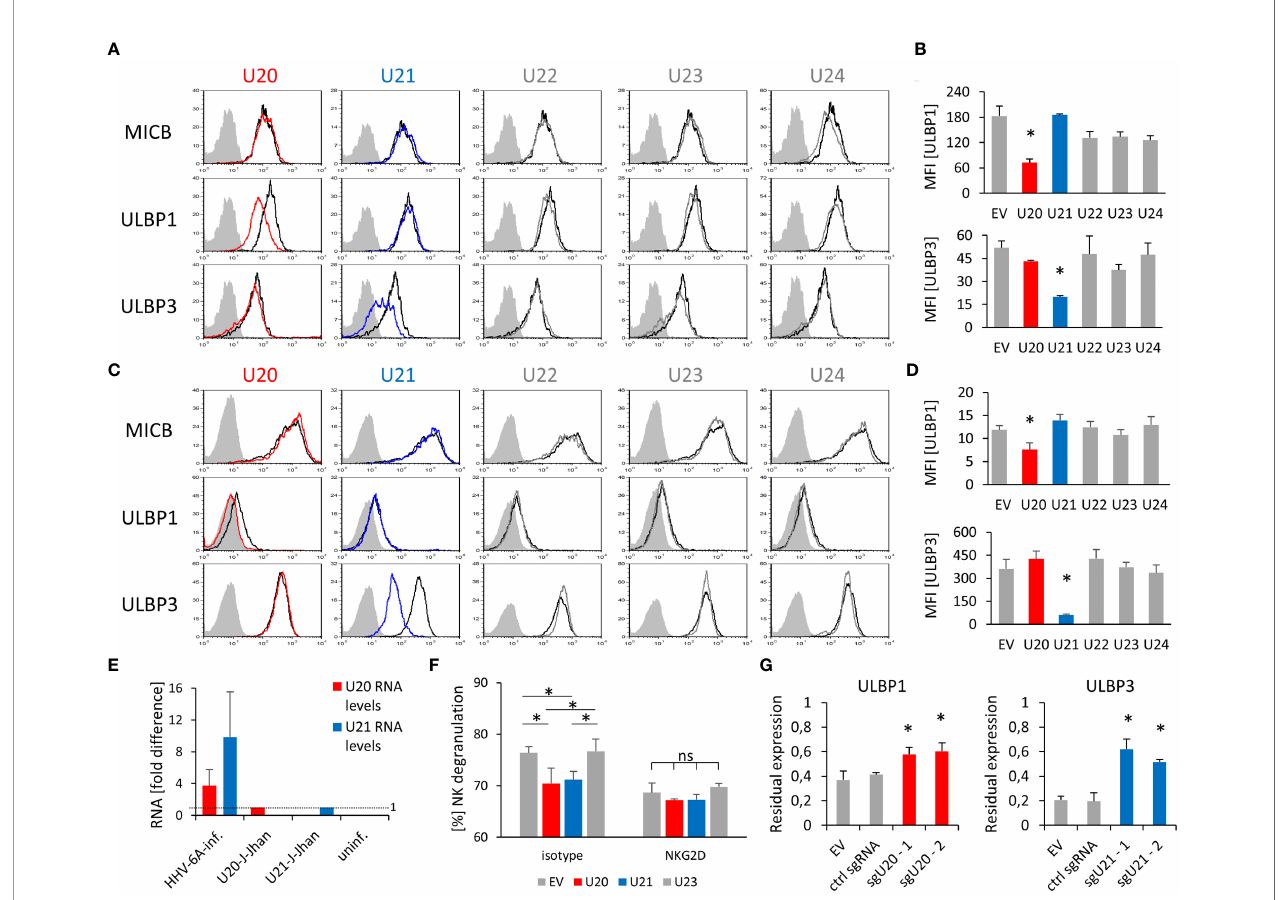
FIGURE 2 | Viral U20 and U21 proteins suppress expression of ULBP1 and ULBP3, respectively. (A) Surface staining of MICB, ULBP1 and ULBP3 on J-Jhan transfectants that overexpress the viral U20 (red) or U21 (blue). The black histogram depicts staining for these ligands on an empty vector control transfectant, the grey shaded histogram depicts an IgG isotype staining on these control cells. Staining of this isotype on the transfectants expressing viral genes was virtually identical. (B) Quanti fi cation of ULBP1 and ULBP3 levels on J-Jhan, statistical analysis was performed using ANOVA with post hoc Tukey Honestly Signi fi cant Difference (HSD) test, *p < 0.05. (C) Surface staining of MICB, ULBP1 and ULBP3 on 293T transfectants that overexpress the viral U20 (red) or U21 (blue). The black histogram depicts staining for these ligands on an empty vector control transfectant, the grey shaded histogram depicts an IgG isotype staining on these control cells. Staining of this isotype on the transfectants expressing viral genes was virtually identical. (D) Quanti fi cation of ULBP1 and ULBP3 levels on 293T, statistical analysis was performed using ANOVA with post hoc Tukey HSD test, *p < 0.05. (E) Comparison of U20 and U21 RNA levels between cells after HHV-6A infection of J-Jhan cells, and J-Jhan cells overexpressing U20 or U21, respectively, by qRT-PCR. GAPDH was used for normalization. (F) NK cell degranulation towards transfected U20-293T (red bar), U21-293T (blue bar) and controls (grey) measured in fl ow cytometry by CD107a. Data is representative from two independent donors. U20 and U21 were found signi fi cantly changed by One-way ANOVA with post-hoc Tukey Honestly Signi fi cant Difference Test, no signi fi cant differences were observed when NK cells blocked with an antibody blocking NKG2D was used (ns). (G) J-Jhan cells transfected with an empty control vector (EV), a sgRNA expressing an irrelevant guide RNA (ctrl sgRNA) or each two sgRNAs targeting U20 (left) or U21 (right) stained for ULBP1 or ULBP3 respectively after three days of infection with HHV-6A. Restoration was signi fi cant (*p < 0.05 in student ’ s t test) both compared to EV and the control guide RNA. Merged data of at least 3 experiments (2 for ctrl guide RNA in ULBP1 staining) with averages and standard error of the means is